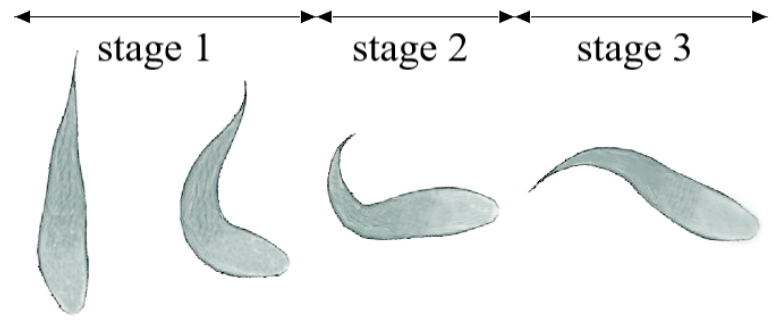
Figure 1. Illustration of the three stages of fish fast start. Stage 1, preparation stage: The middle line of the fish’s body is bent from a straight line in the static state to a C or S shape, the center of mass (COM) of the fish’s body is basically kept still, and the head turns toward the final direction of the fast start. Stage 2, propulsion stage: The tail swings in the opposite direction, the fish obtains the main forward thrust and starting acceleration, and its COM moves along a straight line or an arc. Stage 3, completion stage: The fish enters the cruising state through the small amplitude swing of the tail, or the fish keeps still and starts to slide, while the COM moves along a straight line.